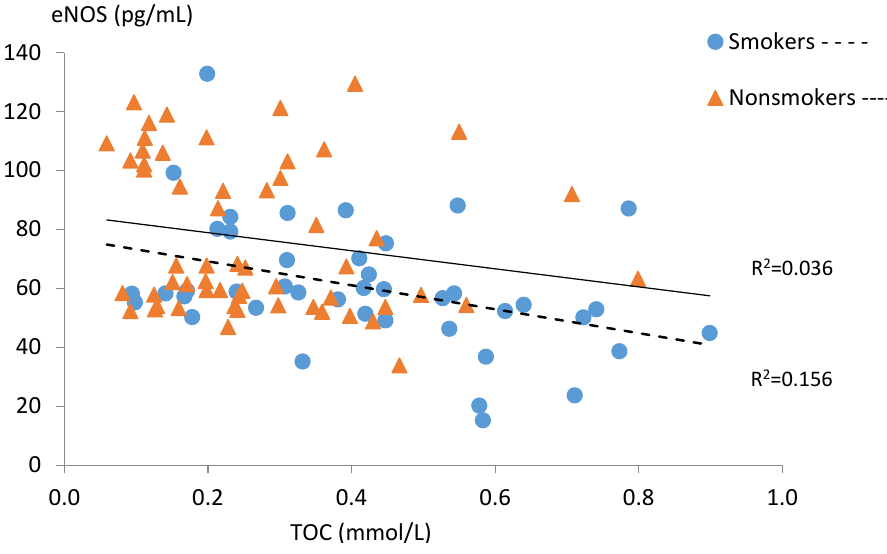
Figure 5. Correlations between serum eNOS and TOC levels in the subgroups of smoking (n = 42) and non-smoking pregnant women (n = 57). Table 5. Multivariable regression analyses (adjusted for age, gestational age, BMI) of NO with eNOS iNOS, markers of oxidative stress and smoking status in the whole group of studied women (n = 99), smoking women (n = 42), and tobacco abstinent group (n = 57).